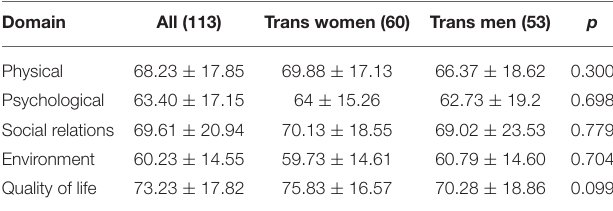
TABLE 2 | Mean WHOQOL-BREF scores in transgender